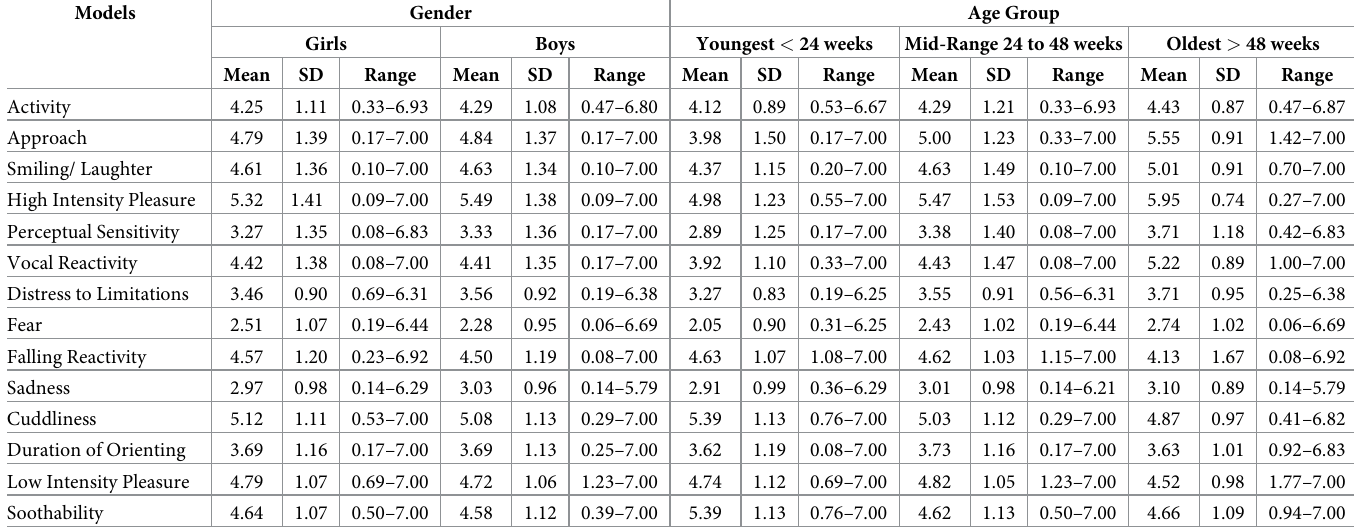
Table 2. Descriptive statistics for the temperament subscales by gender and age group.